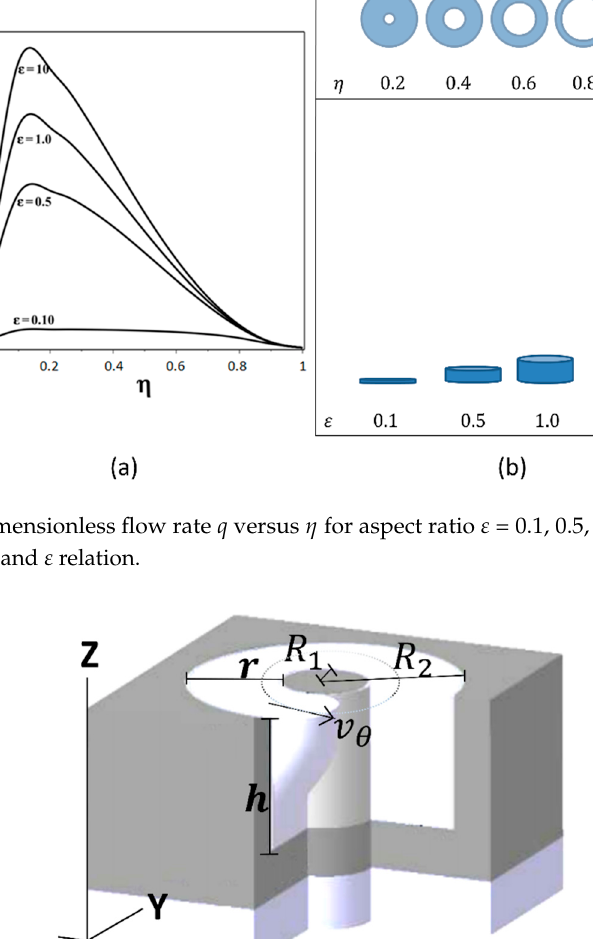
Figure 4. 3D dimensionless velocity profiles for several parameter configurations, in order to show the symmetry and anti-symmetry of the different parameter configurations. 3.3. Comparison of the Proposed Mathematical Model with Other Models Found in Previous Research Literature During the research of the state of art, was found that previous experiments have been done where a circular flow of a weakly conducting fluid was induced by a Lorentz force. Nevertheless, most of them assume that cylinders are infinitely long (cid:4672)(cid:2013) → ∞(cid:4673) and that viscous friction is not present due to the non-existence of bottom effects [19]. Although in a few studies, cylinders are finite [20], and a theoretical Q2D model (quasi-two- dimension model) has been developed for a circular channel with an upper free surface with a very thin fluid layer ((cid:2013) = 0.1 ) . For the Q2D model analytical solution the friction due to the insulating bottom wall has been considered, with two different conditions: (a) idealized assuming that the fluid does not adhere to the circular channel walls, slip boundary condition ((cid:1864) (cid:3046) → ∞) , and (b) non-slip boundary condition ( (cid:1864) (cid:3046) variying between 0 and 100). The Q2D model was based on an averaging procedure in the normal direction due to the pure viscous friction force present in the fluid caused by the bottom wall. In the 2D velocity profile, it has been found that the magnitude of velocity is almost 50% higher when using weakly conducting fluids, compared to highly conducting fluids, which is due to the Hartmann friction presented in high conducting fluids is stronger than the viscous friction presented in weakly conducting fluid. It has been found, that maximum velocity values are closer to the inner cylinder, although as (cid:1844) (cid:3040) grows, the velocity increases while the pro fi le presents a more parabolic shape. Besides, in spite of the viscous friction at the bottom, the fl ow rate grows with (cid:1844) (cid:3040) while, and as expected, a substantial gain was also observed as the parameter (cid:1864) (cid:3046) increases. It was observed that for (cid:1864) (cid:3046) → ∞ , the fl ow rate grows linearly with (cid:1844) (cid:3040) , until reaching a saturation value.